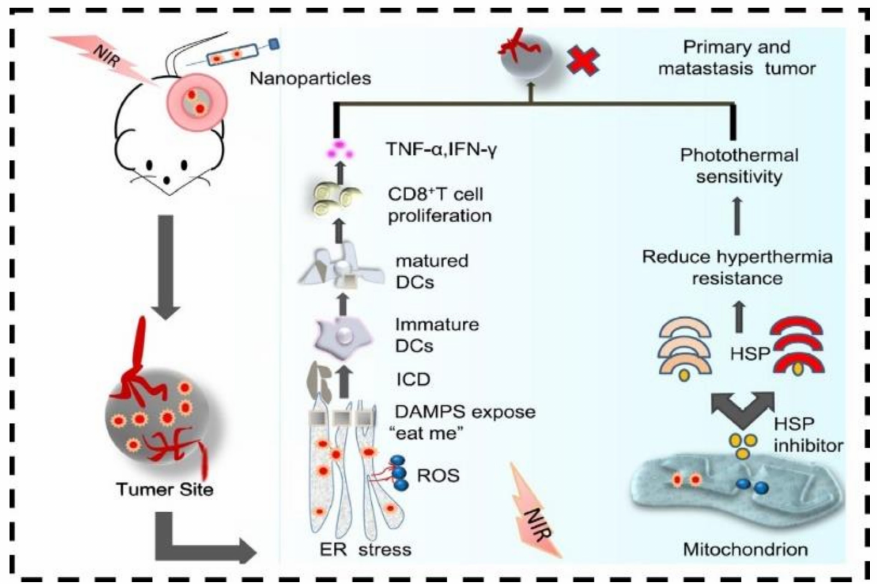
Figure 8. Schematic diagram of anticancer effect of the nanomaterials selective to ER and mitochon- dria under the NIR laser irradiation for photothermal and photodynamic therapy. Adapted with permission from Ref. [131]. 2020,